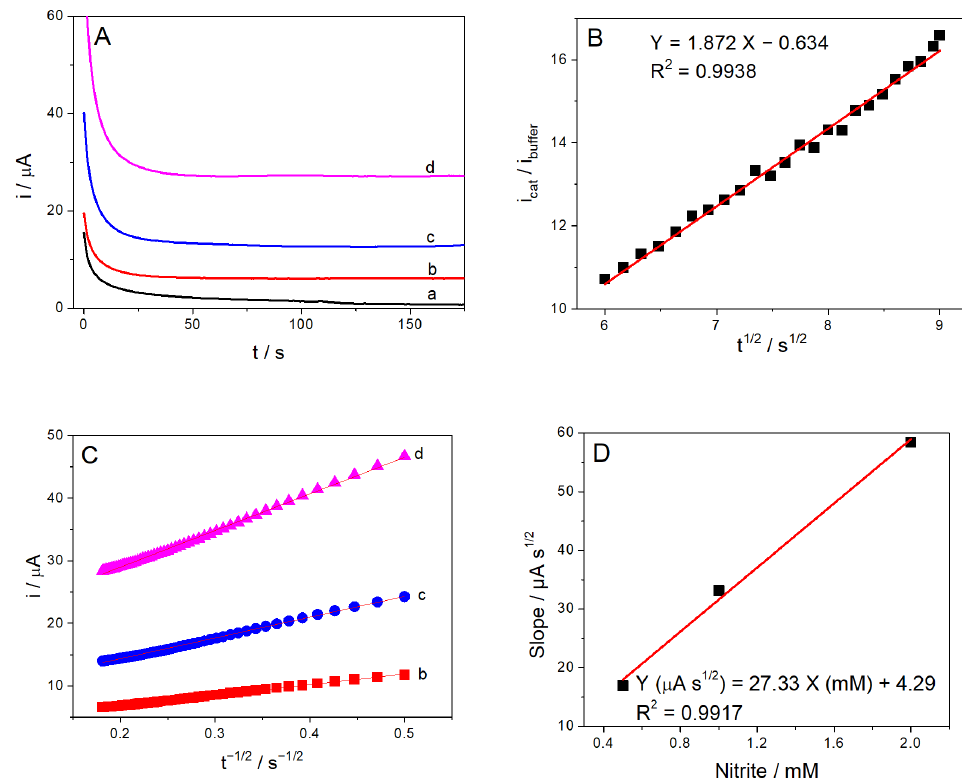
Figure 10. Chronoamperograms recorded for MWCNT-CS/SPE: ( A ) in the absence (a), and in the presence of 0.5 (b), 1 (c), and 2 mM (d) of nitrite. ( B ) i cat /i Buffer vs. the t½ plot derived from (a) and (b). ( C ) Linear segments of plot i vs. t − ½ for 0.5, 1, and 2 mM of nitrite. ( D ) Plot of the slopes vs. the nitrite concentration.